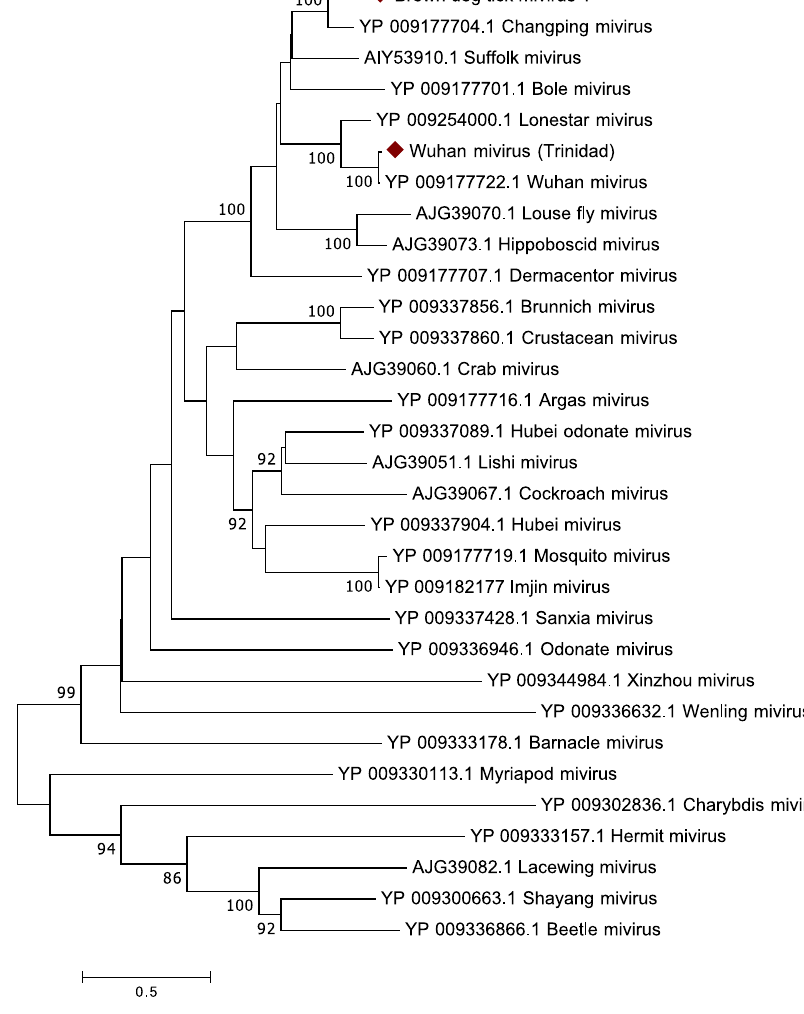
Figure 4. Phylogenetic relationships of Chuviridae based on a 377-aa alignment of the